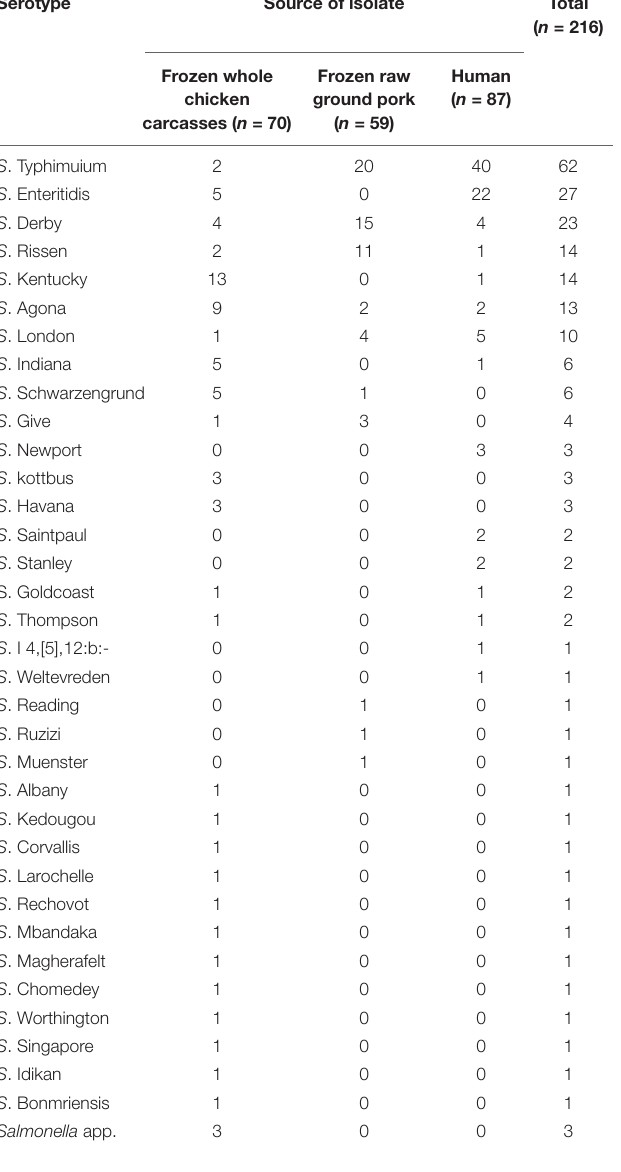
TABLE 1 | Serotypes via slide agglutination and the corresponding number of Salmonella isolates.